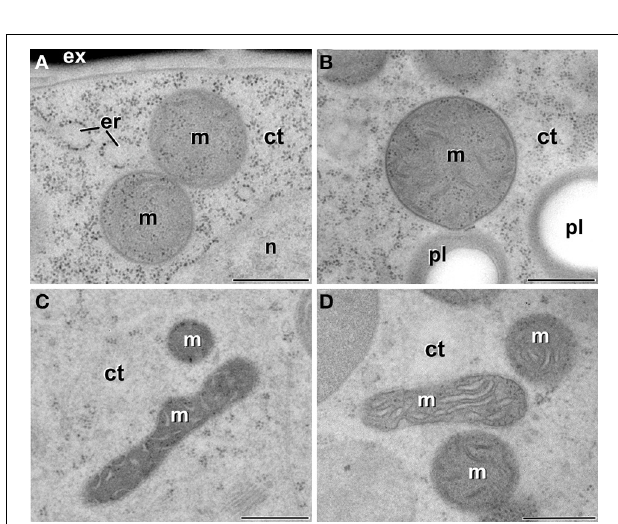
differentiated. Panels (A,B) show electron micrographs of plastids of embryo proper (A) and suspensor (B) cells. ct, cytoplasm; er, endoplasmic reticulum; m, mitochondria; s, starch. Bars: (A,B) : 500nm. Inset: 20 μ m.